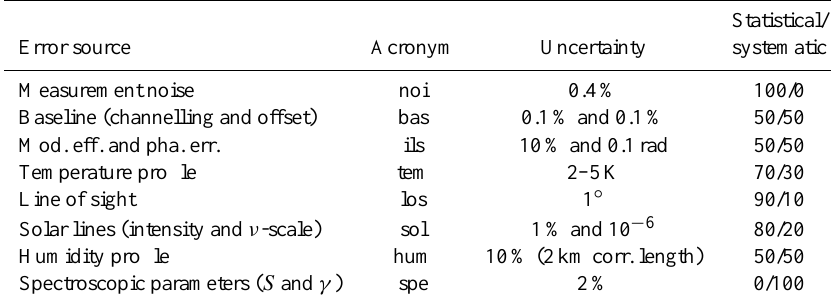
Table 2. Uncertainty sources used for our error estimation. The third column gives the uncertainty value and the fourth column the partitioning of this uncertainty between statistical and systematic